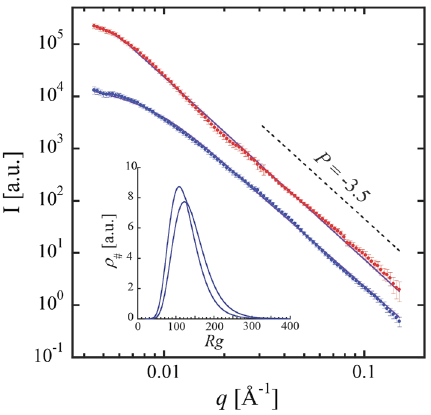
Figure 4. SAXS data for HDPE decomposition products formed at 11.5 ± 5.3 GPa (red circles) and 29.0 ± 1.5 GPa (blue circles) and corresponding fits to Guinier-Porod models (solid lines). The dashed line shows a P = − 3.5 power law for reference. A size distribution of particles corresponding to the 29.0 GPa fit is shown in the inset with lines defining the range of distributions within the parameter